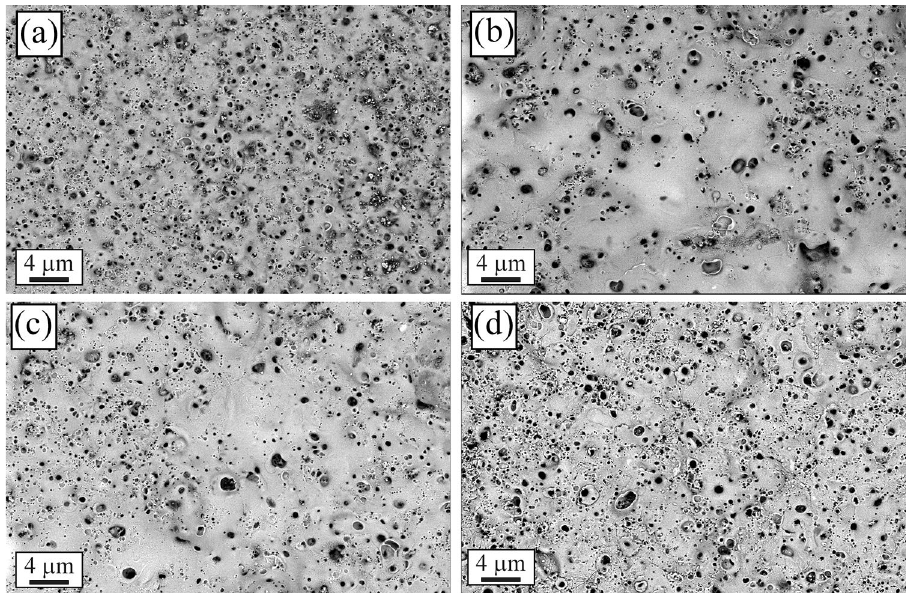
Figure 8. Scanning electron microscope (SEM) images, backscattered electron mode, of the surfaces of the samples after PEO treatment: cast sample ( a ), as printed sample ( b ), annealed sample ( c ), and solution treated sample ( d ).